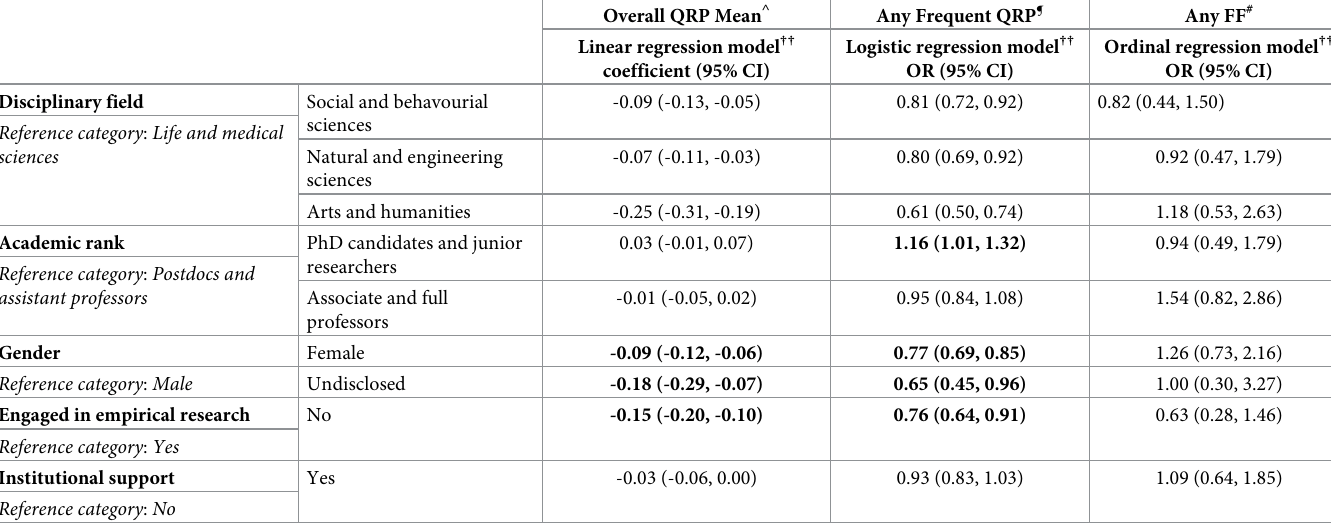
Table 3. Regression coefficients and odds ratios (95% confidence interval) of overall QRP mean, any frequent QRP and any FF stratified by five background characteristics.